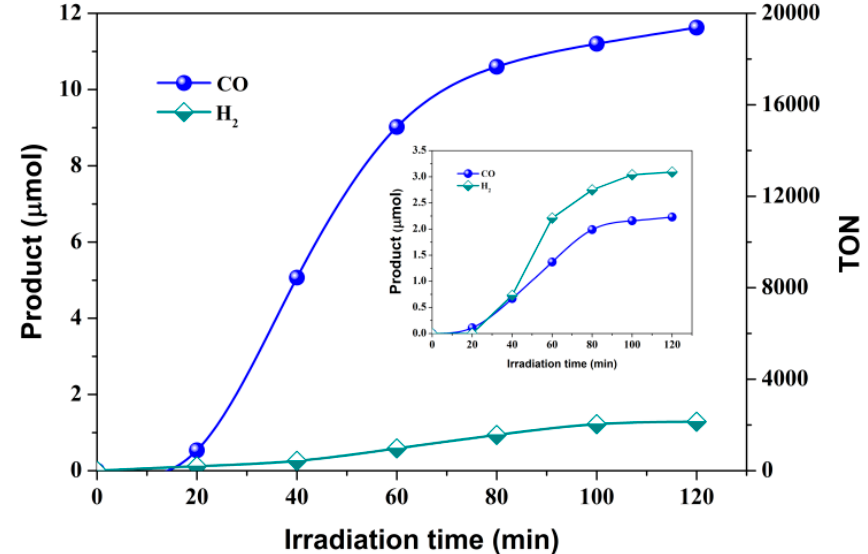
Figure 2. Evolution of CO (blue) and H 2 (dark cyan), and TON CO during bright LED visible-light irradiation in 4 mL CO 2 -saturated DMF/TEOA solution ( v/v , 7:1) containing 6.7 × 10 − 4 M Ru(bpy) 32+ , 0.022 M BIH and 1.5 × 10 − 7 M Fe(phen) 32+ . Inset: without Fe(phen) 32+ .